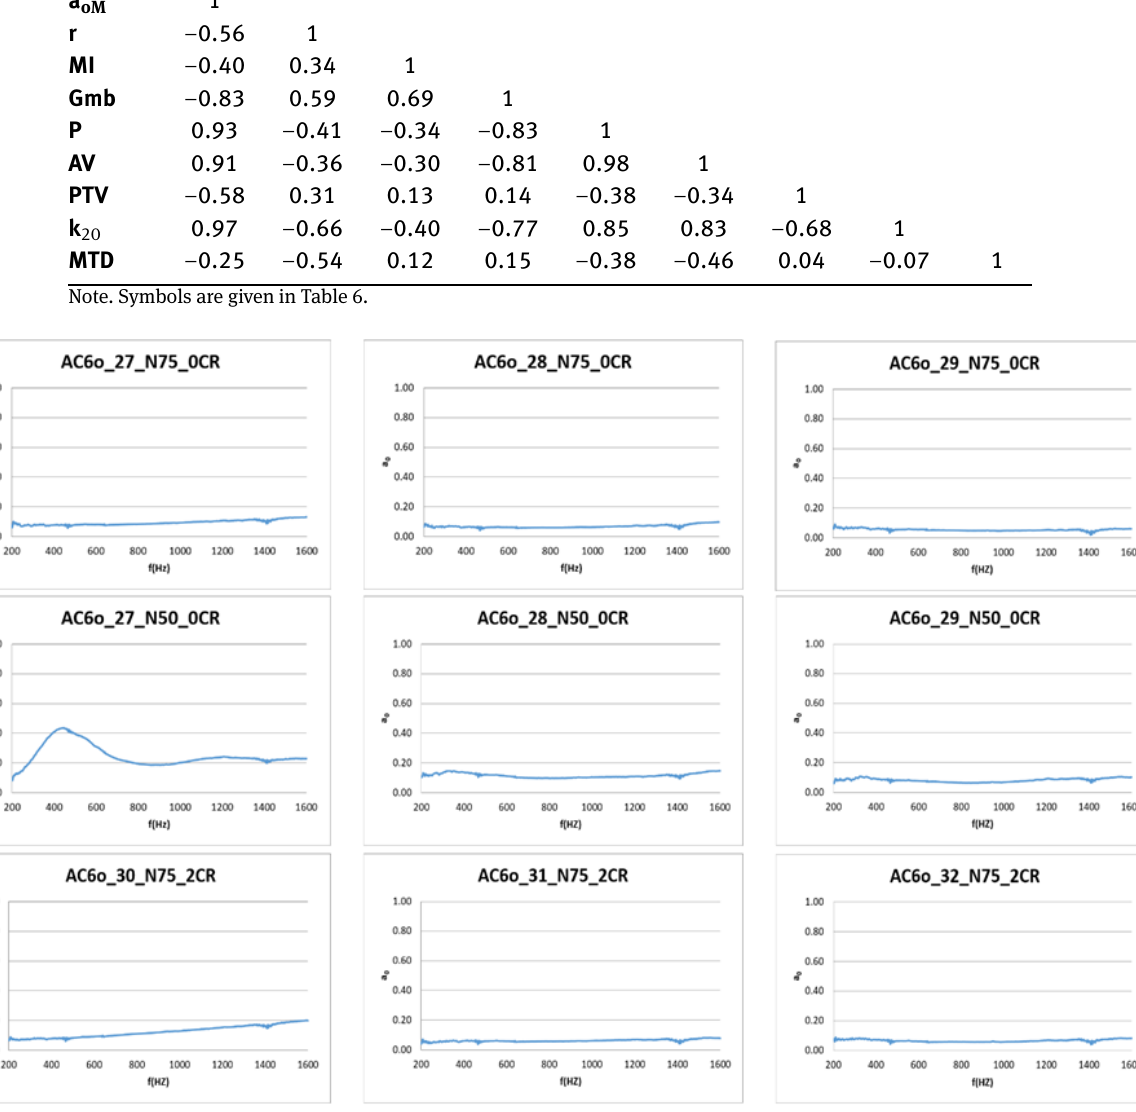
foreseen, while, for open-graded friction courses, airflow resistivity ranges from 1 to 60 kNs/m 4